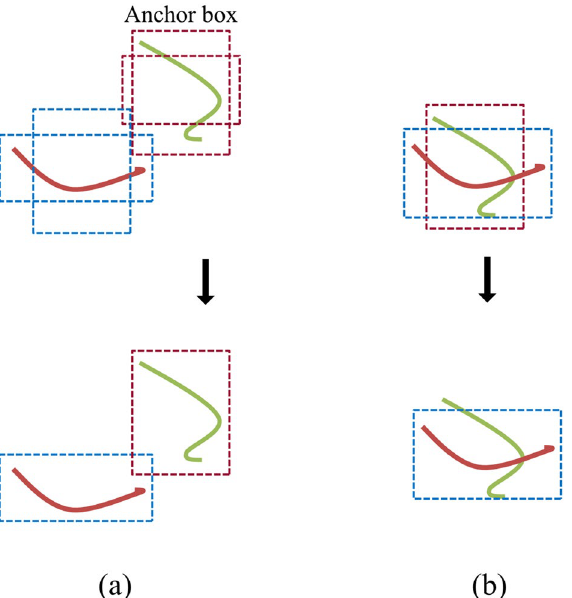
Figure 3. Example of anchor box selection for two objects. The dotted rectangles are anchor boxes over the confidence score threshold. The red and green curves show objects. ( a ) Non-overlapped objects case. One anchor box for each object is selected from two anchor boxes for each object by NMS. ( b ) Overlapped objects case. One anchor box is selected from two anchor boxes by NMS due to close locations less than IoU threshold. Abbreviations: IoU = intersection-over-union, NMS = non-maximum suppression